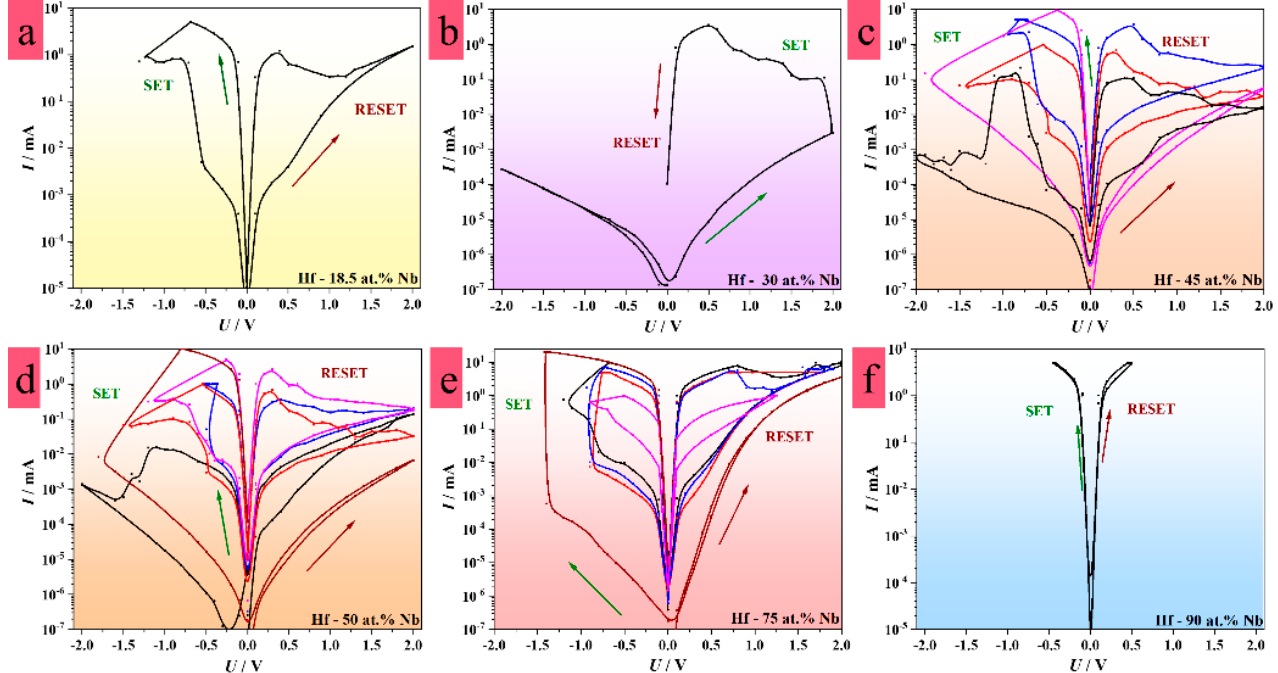
Figure 3. Representative memristive switching hysteretic I-U curves plotted in logarithmic current scale for selected memristors defining different memristive characteristics along the Hf-Nb combinatorial library: ( a ) bipolar switching characteristics of MIM structures grown on Hf-enriched alloys, ( b ) unipolar switching characteristics of MIM structures grown on Hf-enriched alloys, ( c , d ) unipolar and bipolar reversible threshold switching for high-performing MIM structures grown on Hf-45 at.% Nb and Hf-50 at.% Nb alloys, ( e , f ) irregular switching characteristics for MIMs grown on Nb-enriched alloys.